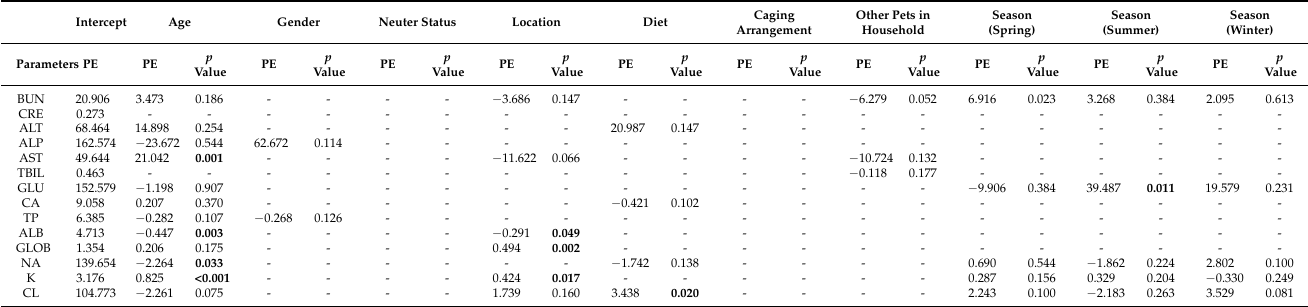
Household was non-predatory, Season was fall. Table 6. Results of multiple regression models of plasma biochemical